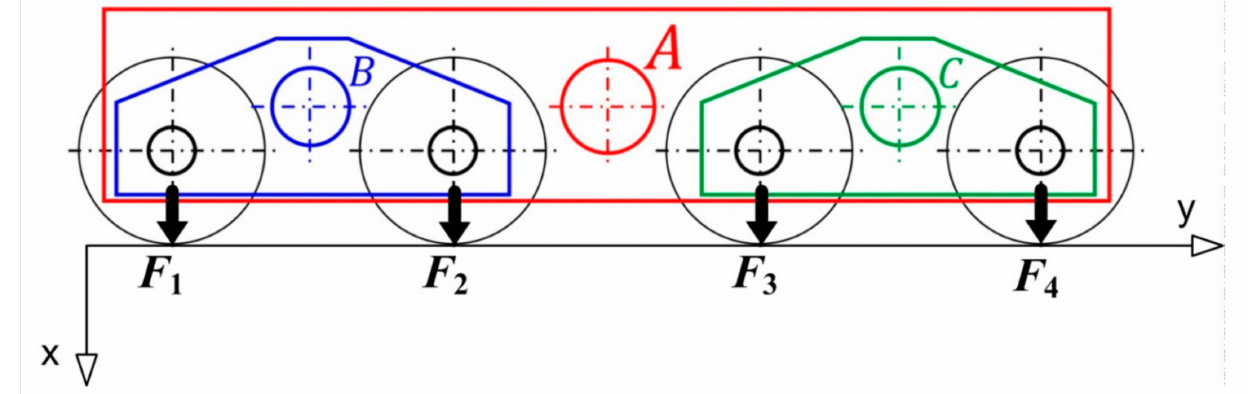
Figure 4. Schematic diagram of loads acting on the bogie of the rotation node